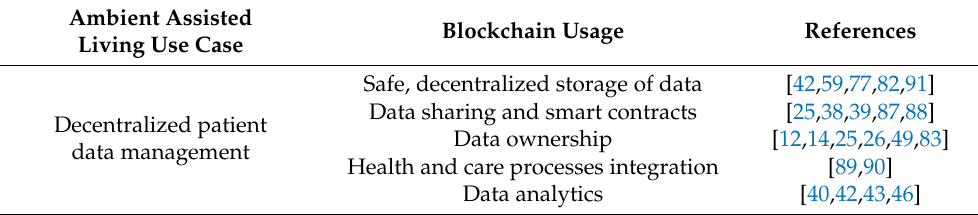
Table 4. Blockchain usage benefits data management in AAL